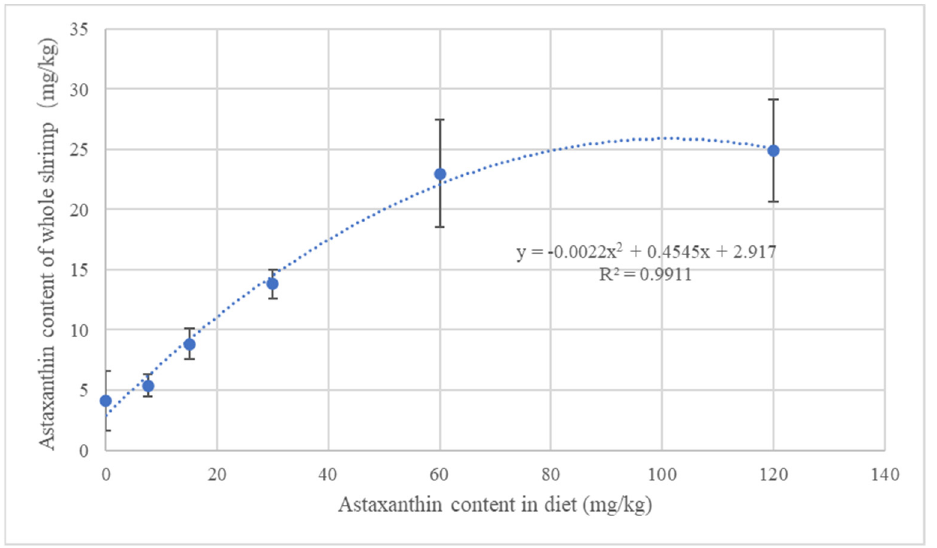
Figure 2. The relationship between the astaxanthin content of whole shrimp and astaxanthin content in diet based on quadratic regression analysis.